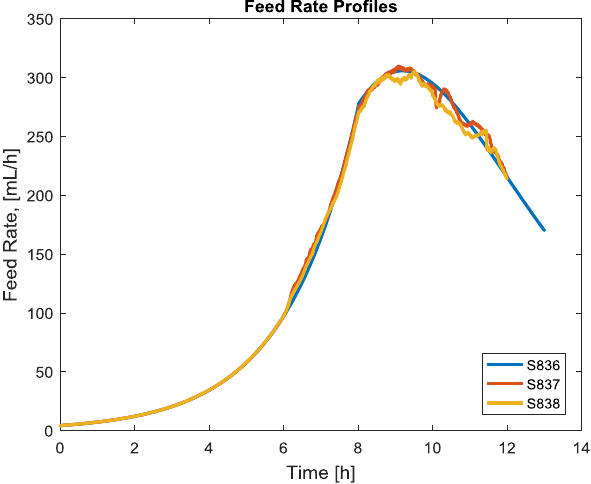
Figure 1. Feed rate profiles from the cultivation experiments used here as the example.